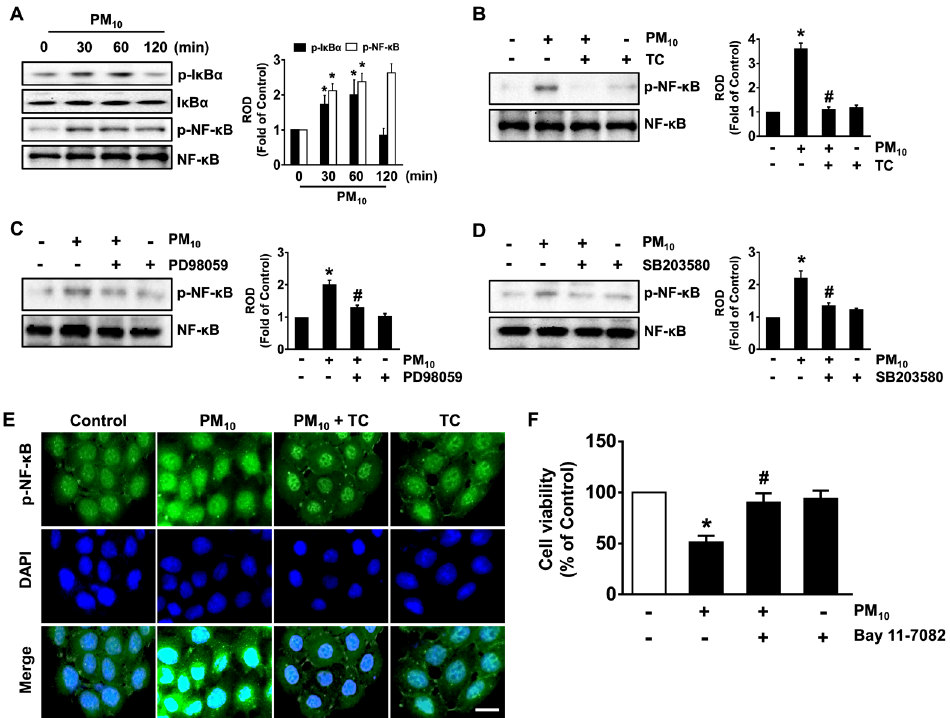
Figure 4. Tart cherry regulates the activation of nuclear factor-kappa B (NF- κ B) responsible for the keratinocyte apoptosis caused by PM 10 . ( A ) Time-dependent response of PM 10 (100 µ g/mL) on the activation of nuclear factor of kappa light polypeptide gene enhancer in B-cells inhibitor alpha (I κ B α ) and NF- κ B in HaCaT cells as determined by Western blot. ( B ) The effect of tart cherry (TC, 200 µ g/mL) on the phosphorylation of NF- κ B is shown. ( C , D ) Cells pretreated with PD980529 (10 µ M) and SB203580 (10 µ M) as inhibitors for ERK and p38 MAPK were incubated with PM 10 for 30 min. ( E ) Representative immunofluorescence staining of NF- κ B in cells co-treated with tart cherry and PM10 is shown. Scale bars, 100 µ m (original magnification × 100). ( F ) Cells pretreated with Bay 11-7082 (10 µ M) as an inhibitor for NF- κ B were incubated with PM 10 for 24 h. Cell viability was determined. ( A – F ) Data are represented as the means ± S.E. n = 3. * p ≤ 0.01 vs. control. # p ≤ 0.05 vs. PM 10 alone. ROD, relative optical density.